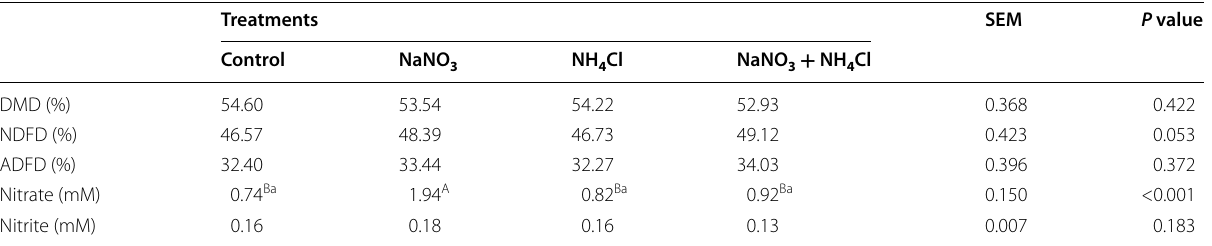
Values with different lowercase and capital superscripts in the same row differ significantly at P < 0.05 and P < 0.01, respectively Table 4 Effects of treatments on the degradability of DMD, and nitrate and nitrite concentrations in ruminal culture